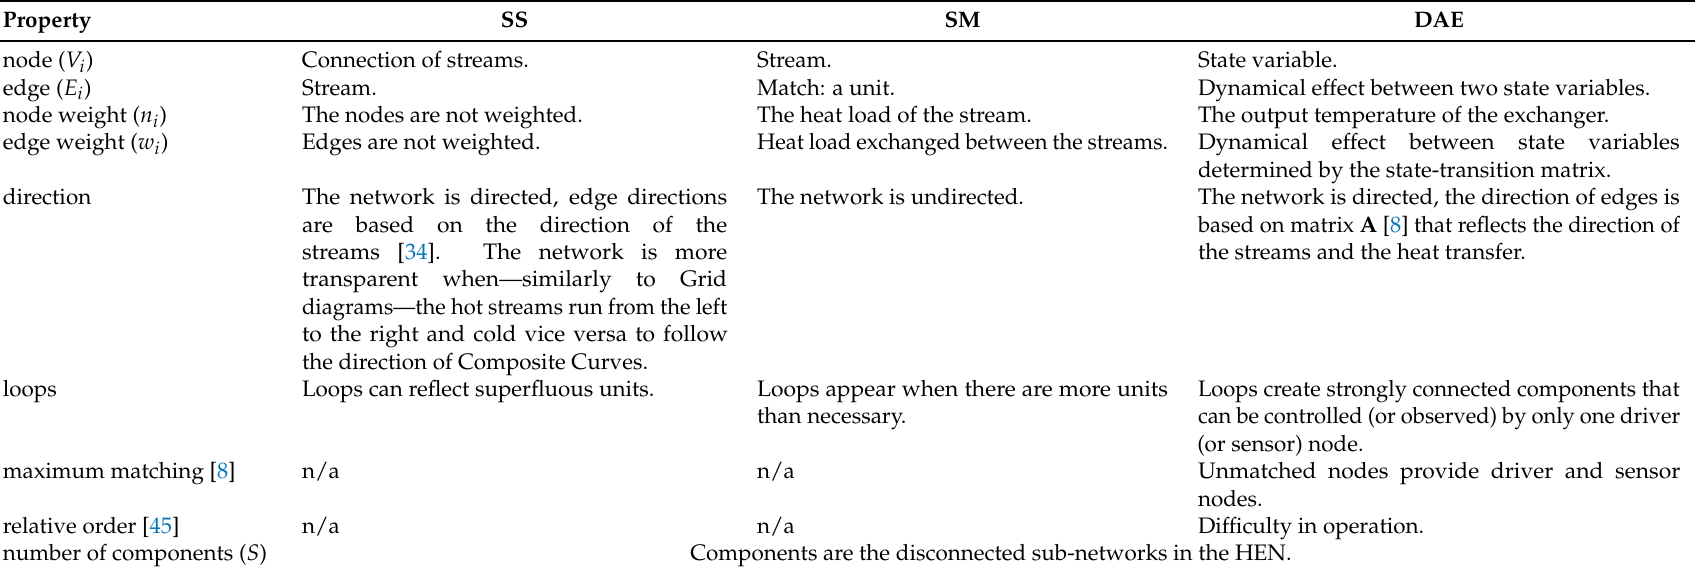
Table 1. Building elements of the studied network-based representations of